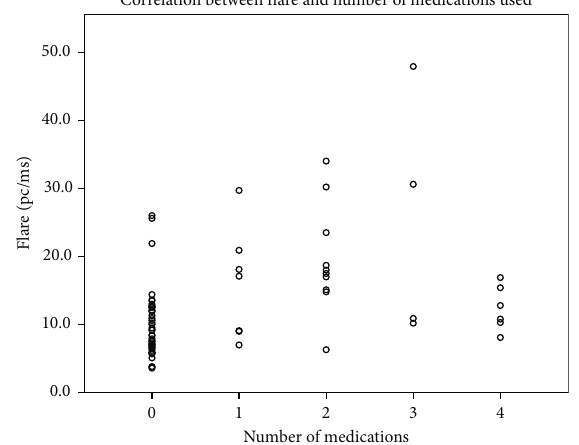
Figure 5: Correlation between flare and the number of different medications used in the glaucoma group; a moderate positive correlation (Spearman’s rho � 0.495, p < 0 .